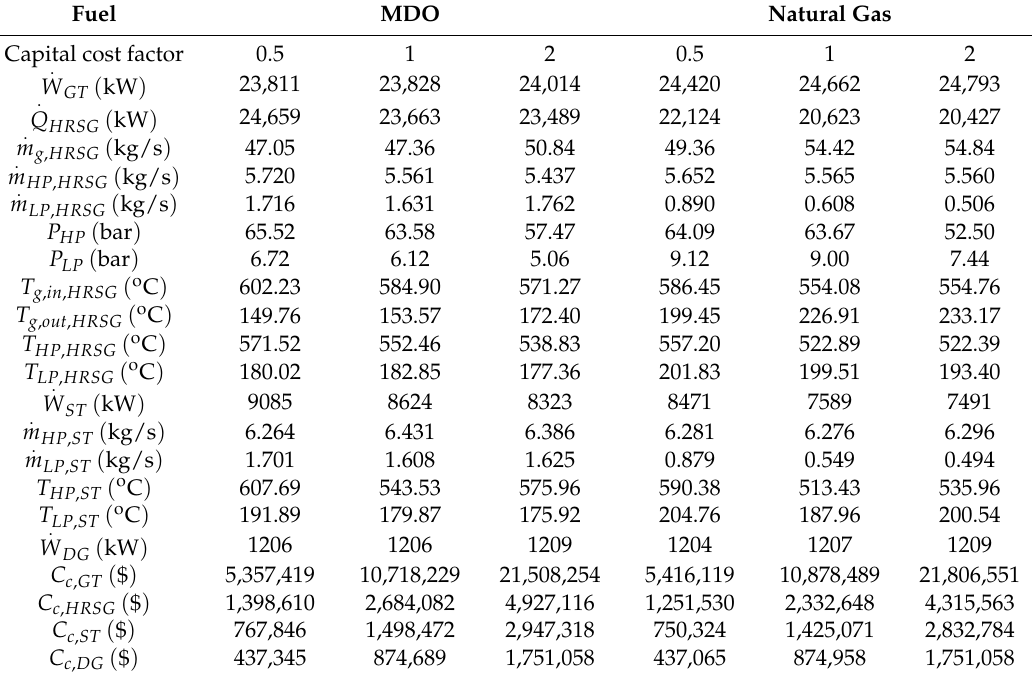
Table 17. Optimal design characteristics and capital cost of components for various capital